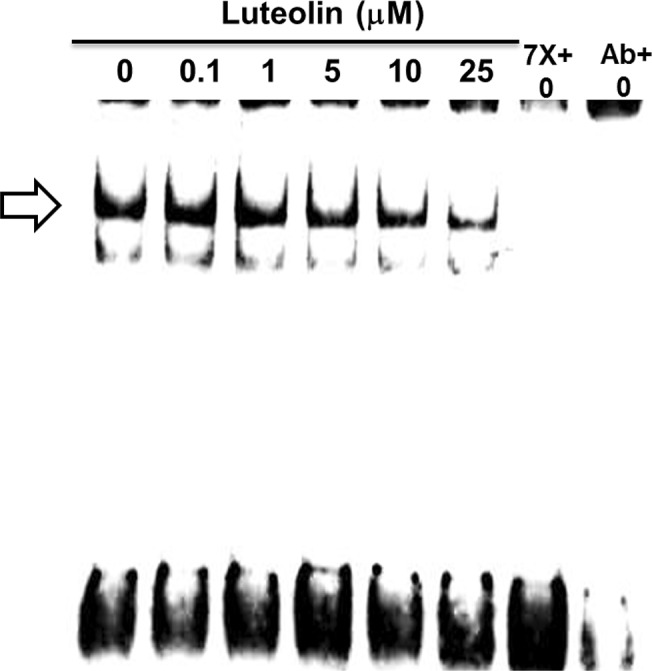
Luteolin weakened the SRE-DNA interaction.The hepatic cells WRL-68 were seeded onto 6-well culture plates and treated with luteolin at 0, 0.1, 1, 5, 10, and 25 μM. After 24 h, nuclear extracts were obtained from the cells and EMSA assay was performed. (⇨) indicates the SREBP-2-SRE interaction band. The image represents one of two independent experiments.